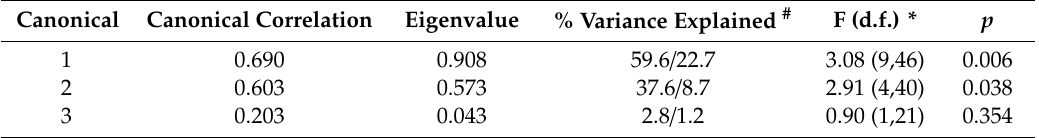
Table 3. Overview of canonical correlations between ergine, ergonovine and peramine concentrations and climate